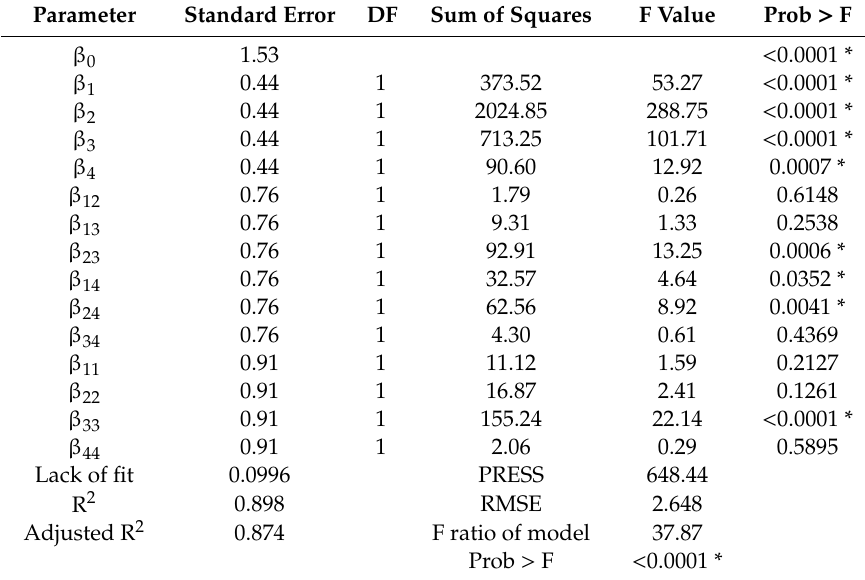
Table 3. Estimated regression coe ffi cients for the model and the analysis of